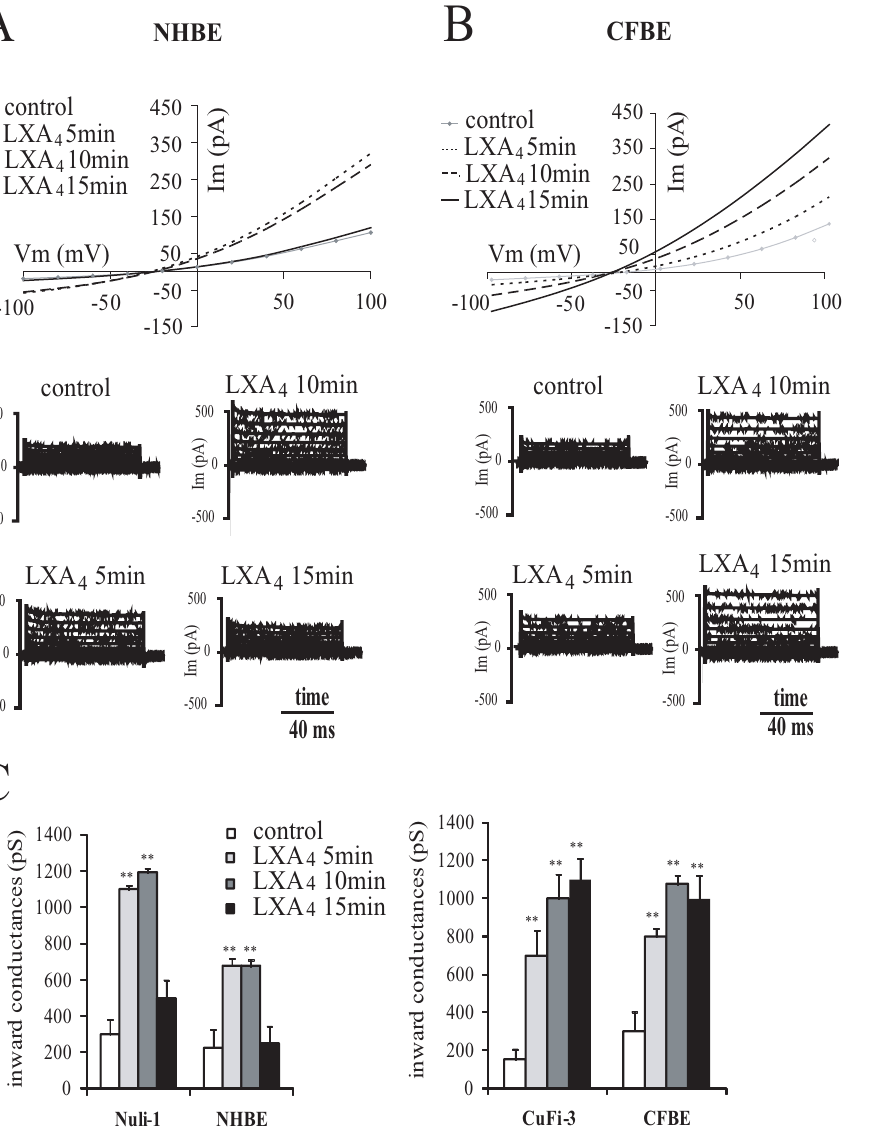
Figure 3. Time dependency of the effect of LXA 4 on whole-cell currents in normal and CF bronchial epithelial cells in primary culture. Typical I-V relationships and corresponding current records obtained before and after 5, 10 and 15 min exposure to LXA 4 (100 nM) in NHBE (A) and CFBE (B) isolated bronchial epithelial cells in primary culture. (C) Mean values corresponding to the time dependency of the LXA 4 effect onwhole cell inward conductances in Nuli-1 (n=8) and in CuFi-3 (n=4) cell lines and NHBE (n=8) and CFBE (n=6) primary cultures (**p , 0.01).